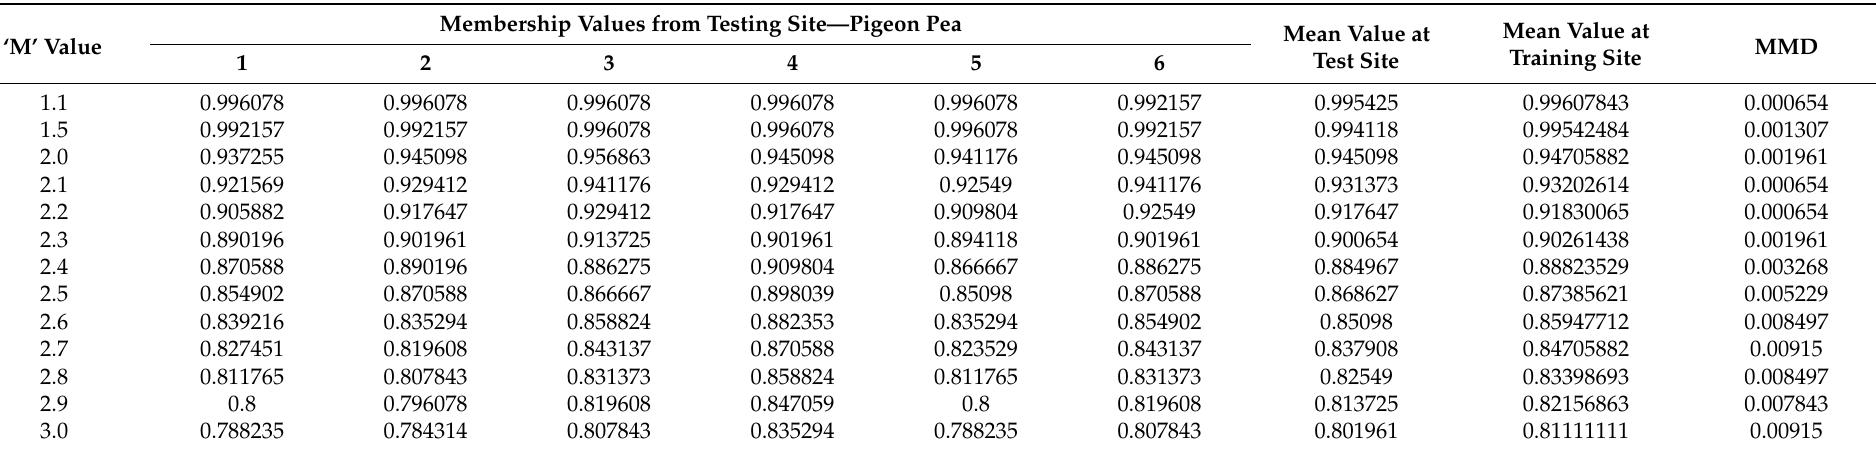
Table 5. Varying ‘m’ values with MMD exhibiting Proximity of Pigeon Pea Training Fields to the Pigeon Pea Test Fields—Mean training parameter based PCM classifier.